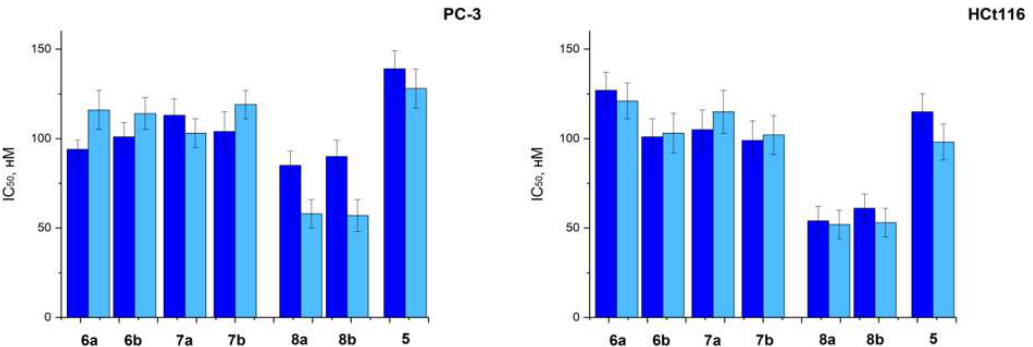
Figure 3. The c combined activity of compounds in vitro as a function of incubation time after ad- Figure 3. The ccombined activity of compounds in vitro as a function of incubation time after ministering (dark blue columns—48 h, light blue columns—72 h). administering (dark blue columns—48 h, light blue columns—72 h).